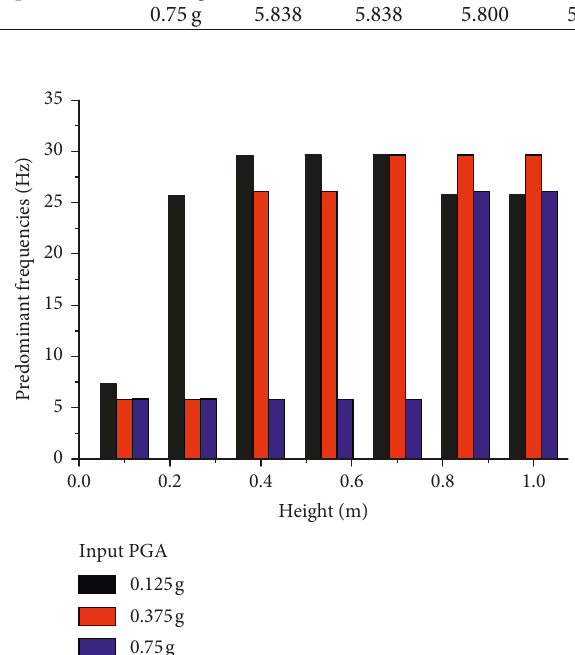
Figure 13: Predominant frequencies of soil at different positions.